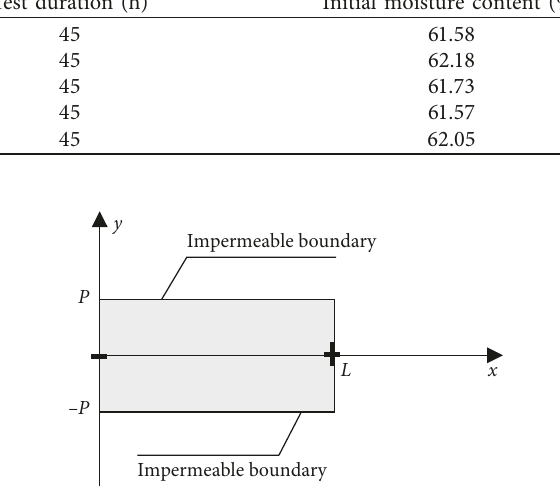
Figure 6: Electroosmosis method calculation diagram for planar two-dimensional